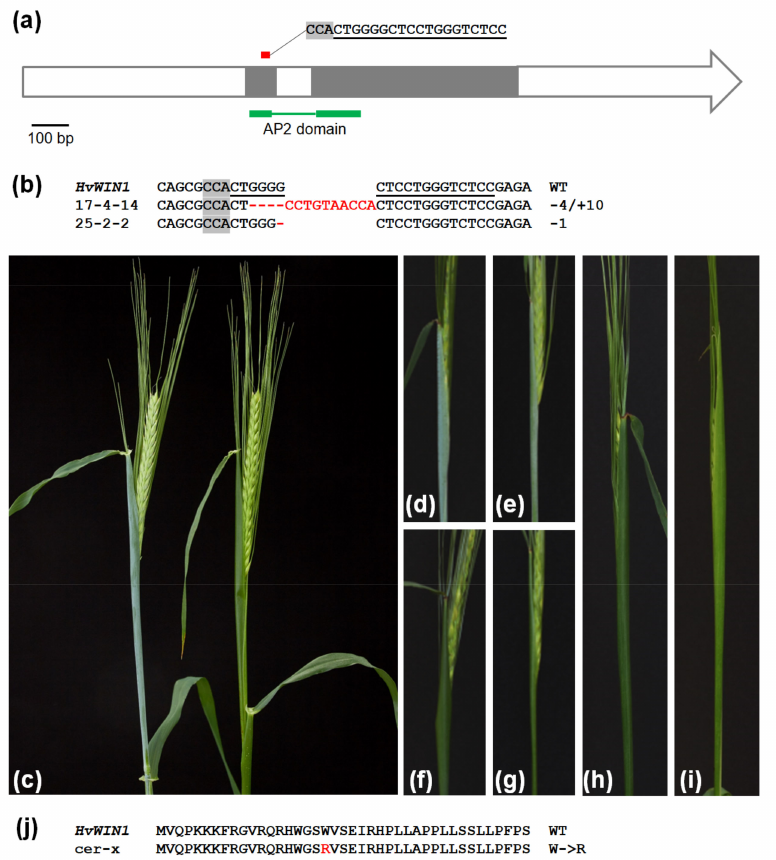
Figure 1. Genotype and phenotype of win1 KO and cer-x.60 mutants. ( a ) Position and structure of the target motif in the WIN1 gene. The coding sequence is shown in grey, AP2 domain in green, target motif in red. ( b ) WIN1 gene mutations in the selected homozygous lines (Lines 17-4-14 and 25-2-2) are given as examples. Target motif is underlined and in bold; protospacer-adjacent motif is indicated by grey background. ( c ) “Golden Promise” wild-type (left) and glossy leaf sheath win1 KO plants (right). ( d ) “Bonus” wild-type. ( e ) “Bowman” wild-type. ( f ) cer-x.60 mutant in “Bonus”. ( g ) cer-x.60 mutant in “Bowman”. ( h ) F1 win1 KO × cer-x.60 (in “Bonus”) hybrid. ( i ) F1 win1 KO × cer-x.60 (in